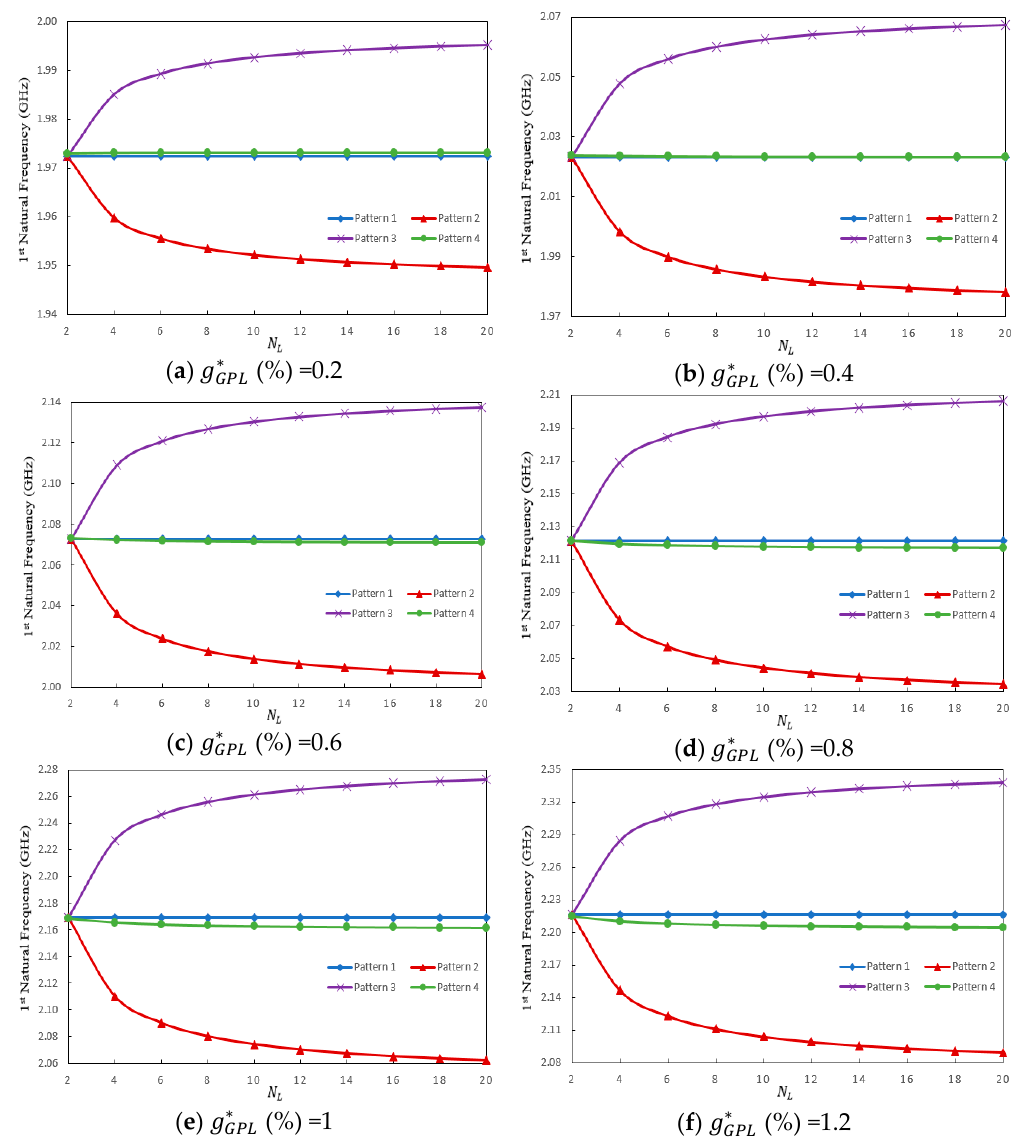
Figure 5. Variation of the first natural frequency (GHz) of the composite curved nanobeams with the total number of layers and di ff erent patterns; θ 0 = 1 Rad , µ = 1 nm , k 1 = k 2 = 0. Appl. Sci. 2019 , x , x FOR PEER REVIEW